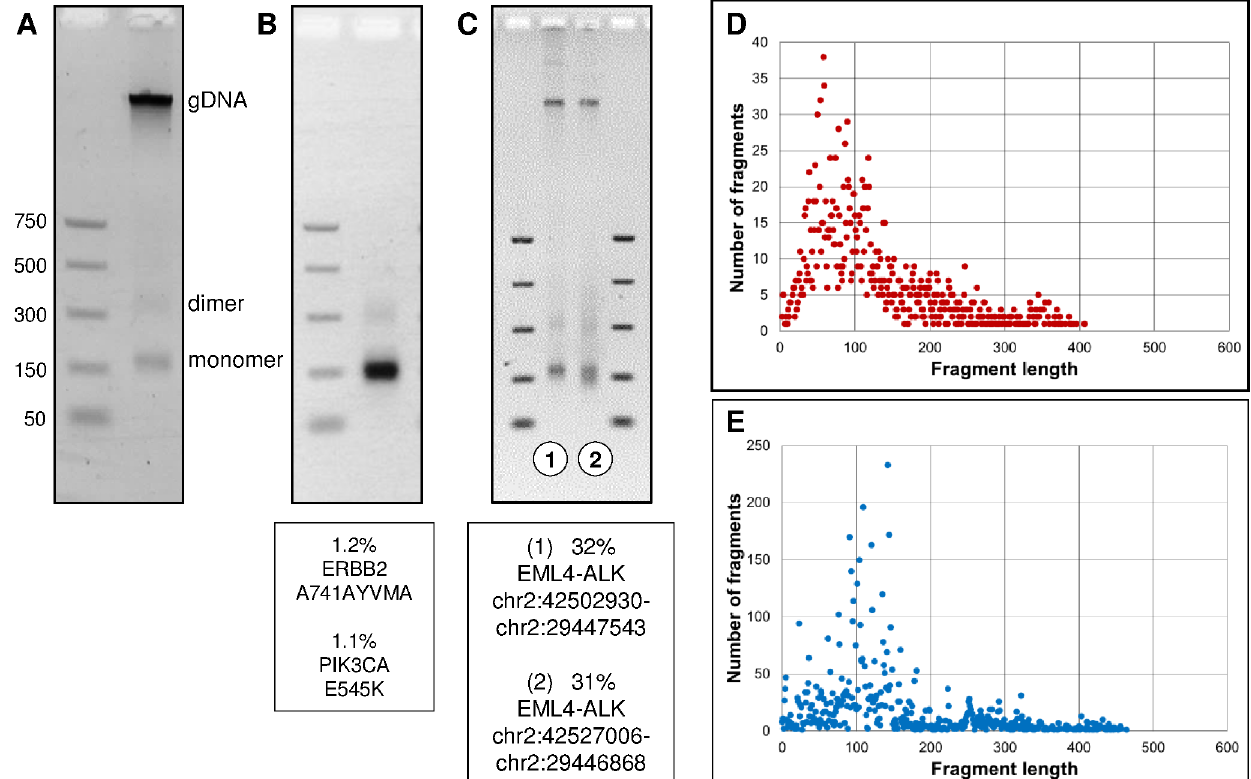
Fig 1. Circulating tumor DNA is detected in the nucleosomal fraction of cfDNA. (A) The DNA purifiedfrom plasma often consists of short nucleosome-sized monomer, dimer, trimer, etc. DNA fragments and high molecularweight gDNA. (B) The cfDNA extracted from the plasma of a patient with NSCLC appearedto be exclusivelynucleosomal fragments, and tumor-specific mutationsshown below the gel were detected in the resulting genomicanalysis. (C) The cfDNA isolatedfrom two NSCLC patients that had independentEML4-ALK fusions. Sequencing revealed that the tumor fraction (minor allelefrequency of the EML4-ALK fusion) was 32% in the patient sample on the left and 31% in the patient sample shown on the right. (D) Size distribution of tumor derivedDNA fragments (top) and germlineDNA fragments (bottom). The EML4-ALK fusion tumor data was calculatedby combiningthe uniqueread informationfrom four independentfusion genes found in four separateNSCLC patients, including the two shown in Fig 1C.